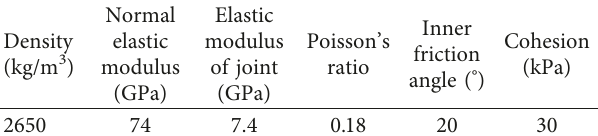
Figure 4: Loading curve. Table 2: Geotechnical parameters used in